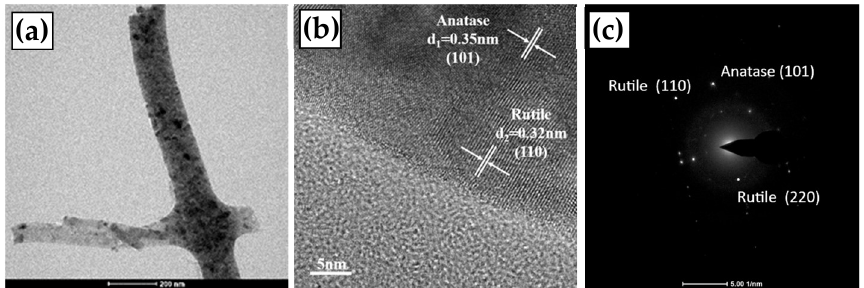
Figure 4. TEM observation of the TiO 2 fiber annealed at 800 °C; ( a ) TEM image of local magnification; ( b ) HRTEM image and lattice annotation of anatase and rutile, and ( c ) calibration of diffraction pattern.